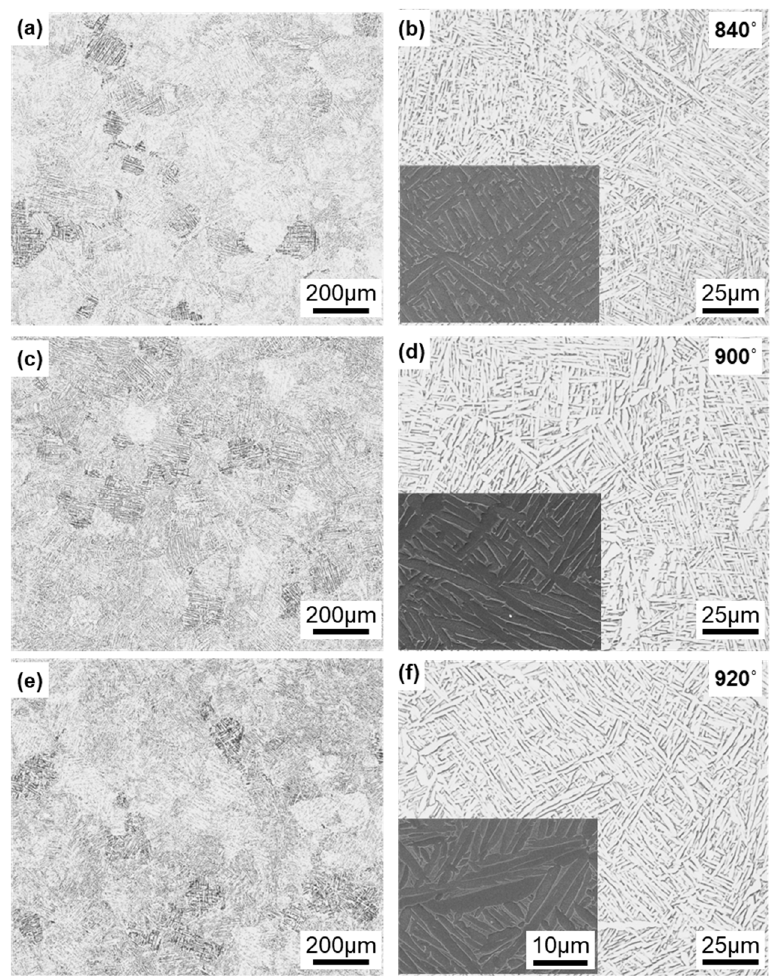
Figure 7. Optical microscopy and SEM images of Ti-6Al-4V alloy annealed at ( a , b ) 840, ( c , d ) 900, and ( e , f ) 920 °C for 2 h after laser sintering.